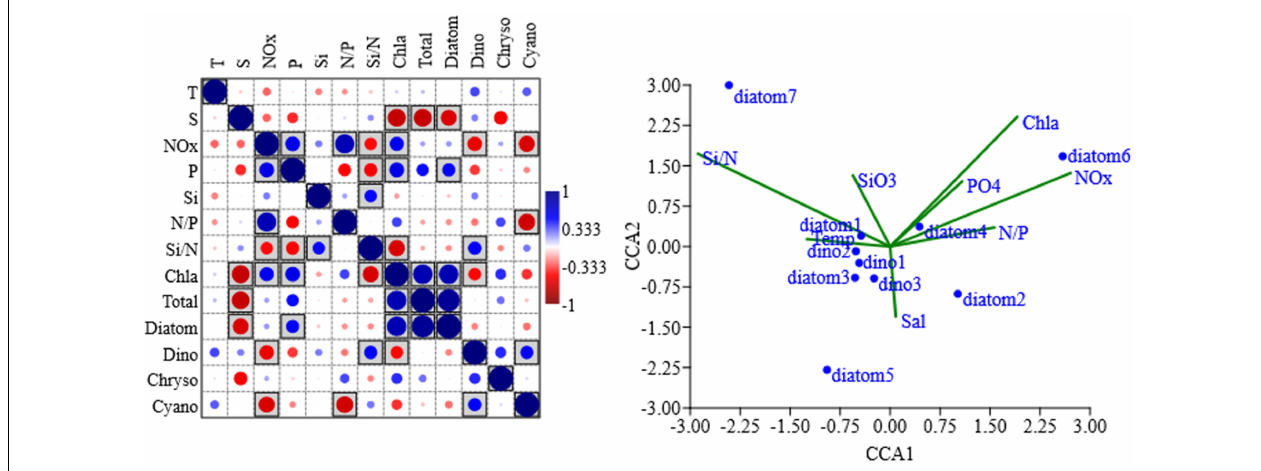
FIGURE 6 | Spearman’ correlation between different algae groups and environment factors (Left) and CCA triplot of dominant species (Right) . p < 0.05 in square box dot color and size represented correlation value; there were 10 response variables: diatom1–7 represent Thalassionema nitzschioides , Nitzschia spp., Thalassiosira sp., Coscinodiscus subtilis , Pseudo-nitzschia delicatissima , Paralia sulcata , Chaetoceros laevis , dino1–3 represent Gymnodinium lohmannii , Prorocentrum lenticulatum , Ceratium furca ; eight explanatory variables: temperature (Temp), salinity (Sal), chlorophyll a (Chla), NO x , PO 3 − 4 (PO4), SiO 2 − 3 , N/P, Si/N. Sample and species score matrix in CCA and Spearman correlation matrix were shown in Supplementary Tables 5, 6 ,